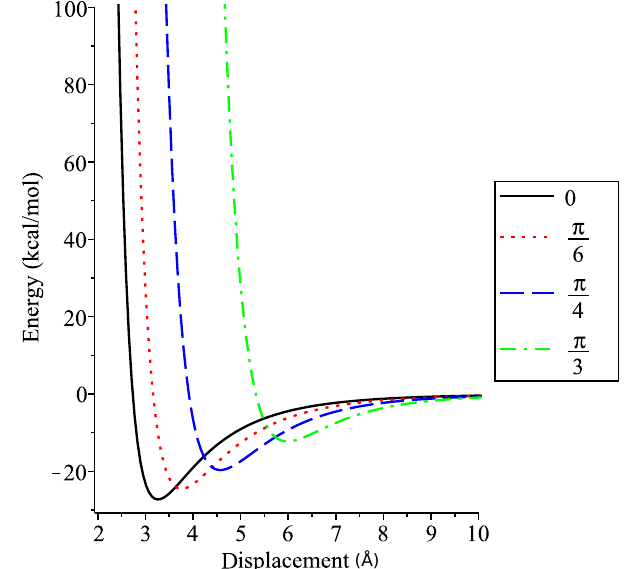
Figure 8. Interaction energy within coronene dimer for fixed angles.